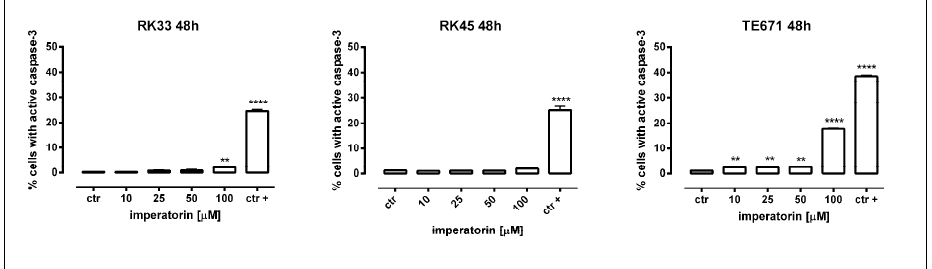
Figure 3. Imperatorin induces apoptotic cell death in human rhabdomyosarcoma and larynx cancer cells. RK33, RK45, and TE671 cells were incubated for 48 h with different concentrations of imperatorin (10–100 µ M) and camptothecin (5 µ M) as a positive control (ctr + ) and analyzed by flow